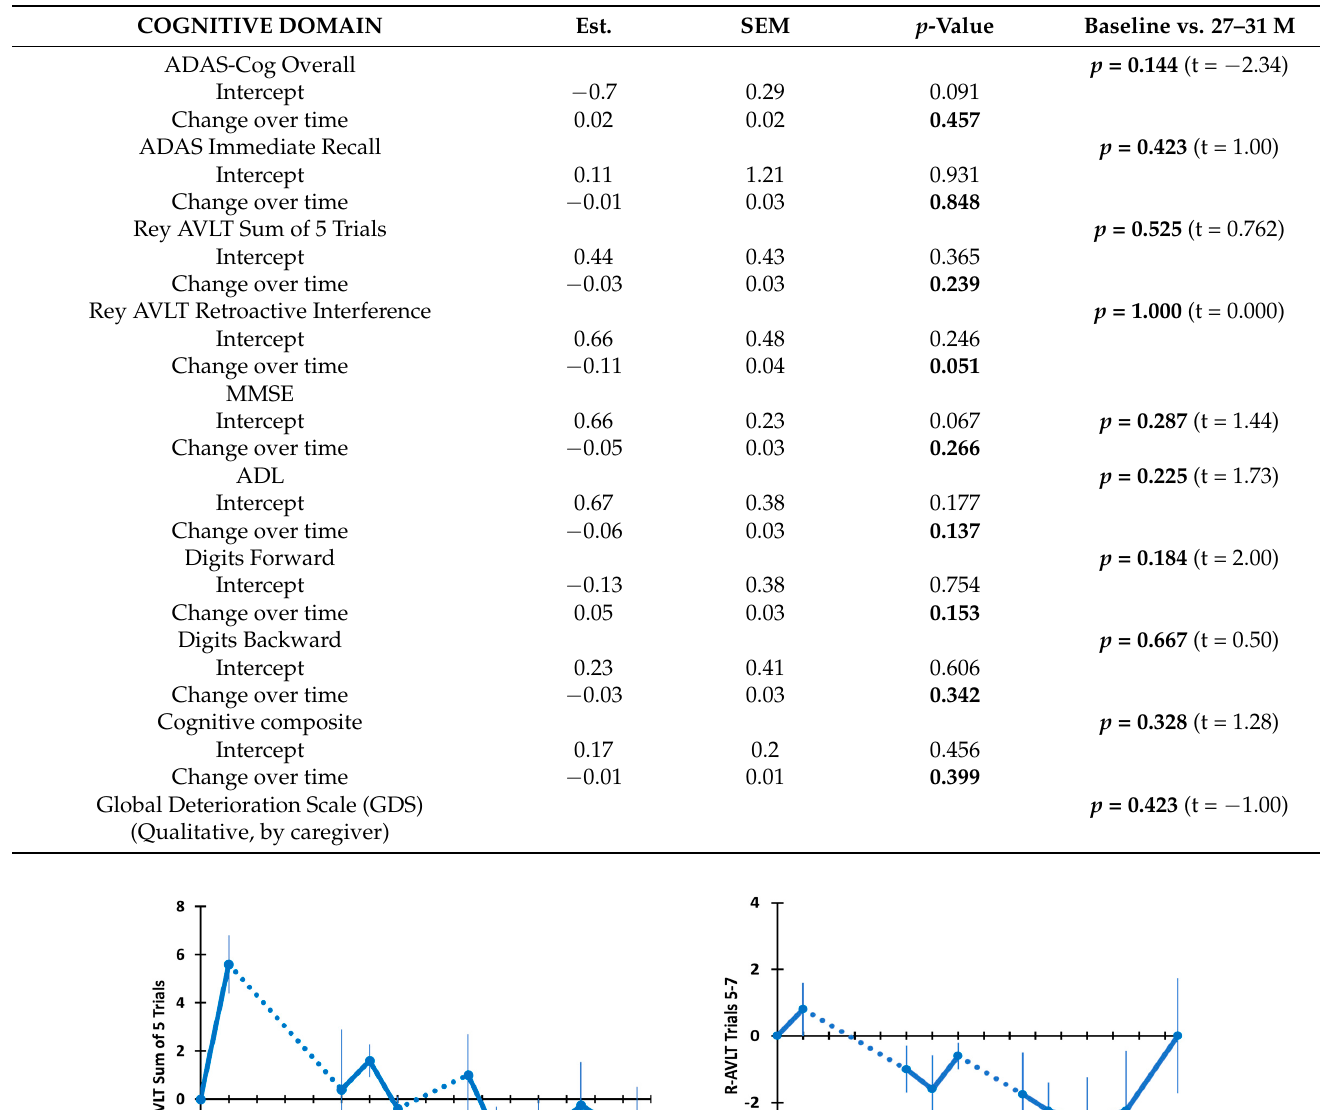
Table 2. Trajectory of change over time in cognitive scores (mixed-effects model) and baseline vs. 27–31 M comparison.